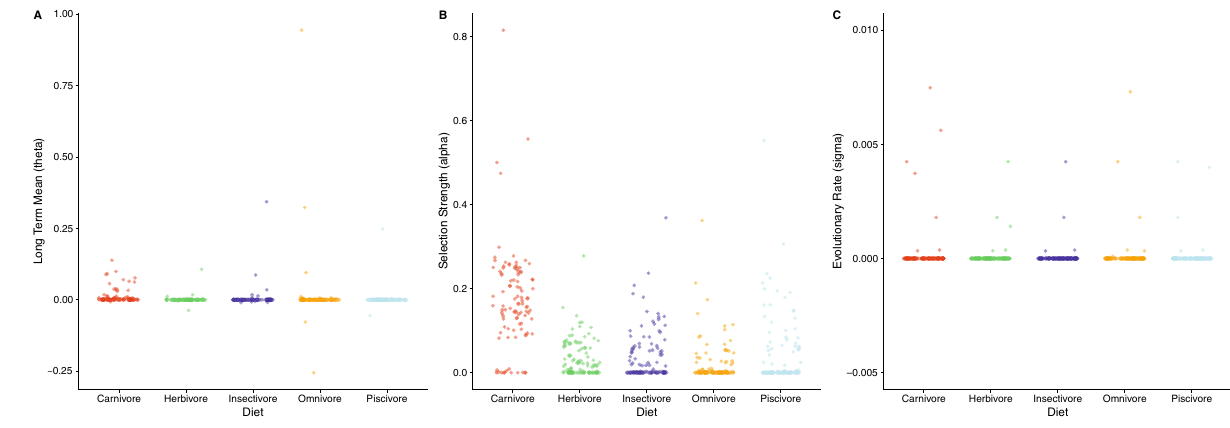
Fig.3|Modelsofbodysizeevolutionintetrapods. Parameterestimatesfromthe best fi tting model of body size evolution under different evolutionary regimes de fi nedbytrophicecology(80OUMAand20OUMVA),for100sampledsimulated evolutionary histories. A Long-term mean ( θ ), B selection strength ( α ), and